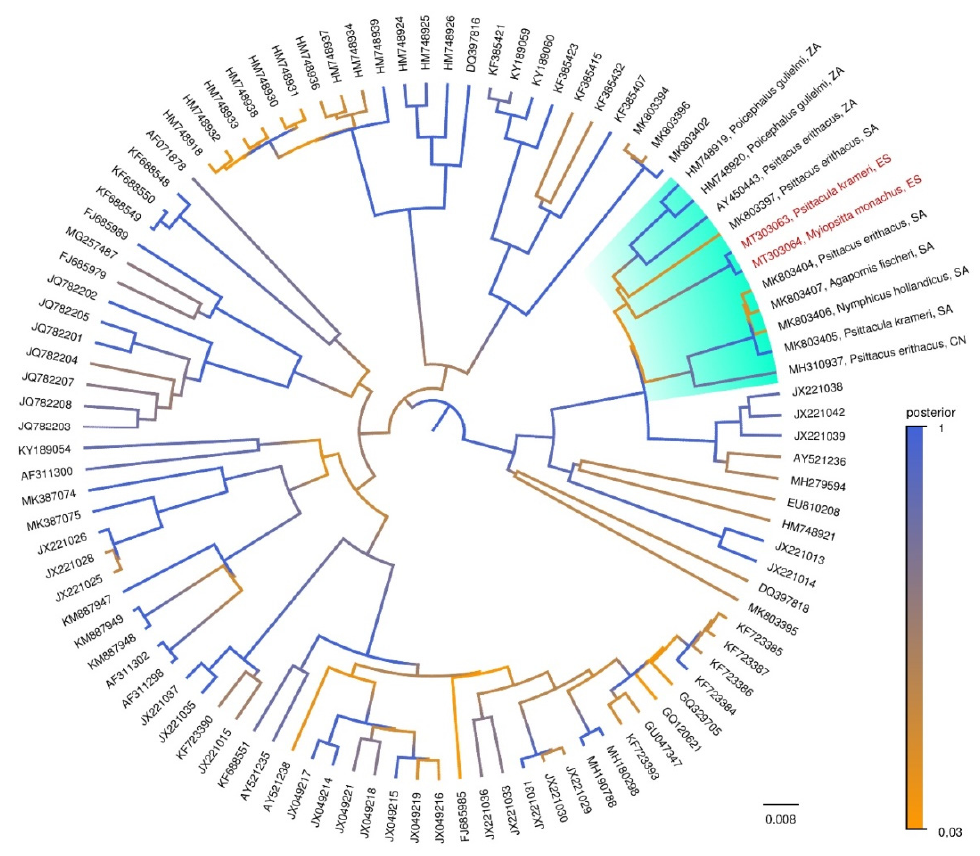
Figure 1. Maximum Clade Credibility tree for the beak and feather disease virus (BFDV) rep gene partial nucleotide sequences (603 bases). Posterior probabilities for the nodes are represented with a colour gradient scale. All partial rep sequences are identified by GenBank accession number. The clade that includes the novel circovirus genotype is highlighted and also shows species and country codes (ISO 3166-1 alpha-2). The detailed list of host species, country of virus isolation and genotypes are presented as supplementary database 1.